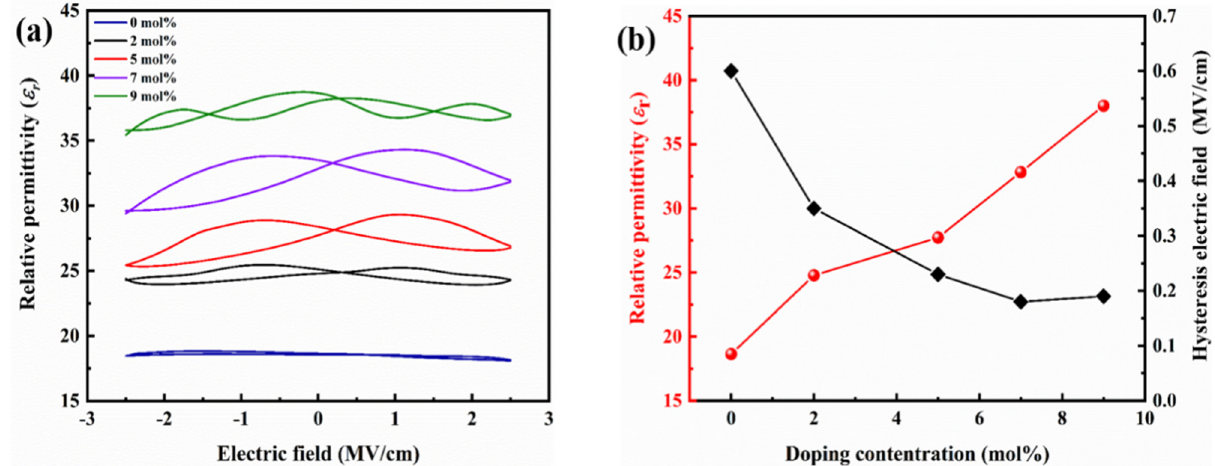
Figure 6. ( a ) Ɛ r – E curves and ( b ) hysteresis electric field of Ce: HZO thin films with different Ce concentrations.